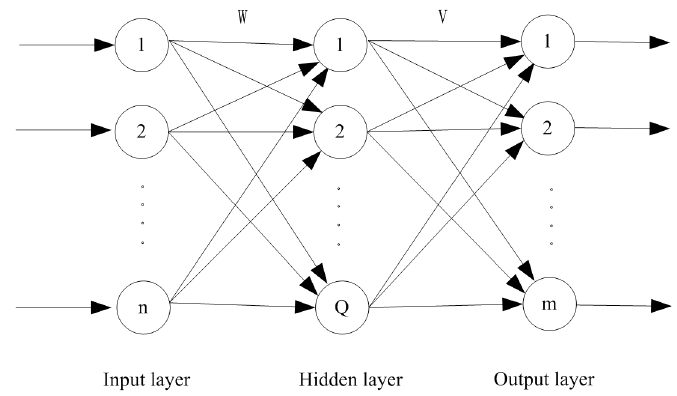
Figure 1. A standard structure of ELM.